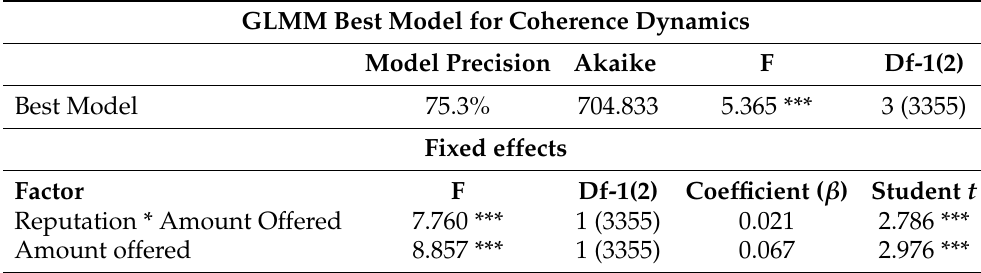
Table 4. Generalized Linear Mixed Models 4. Coherence dynamics.